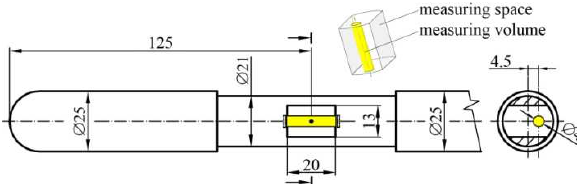
Fig. 1 . The shape design and dimensions of the extinction probe head